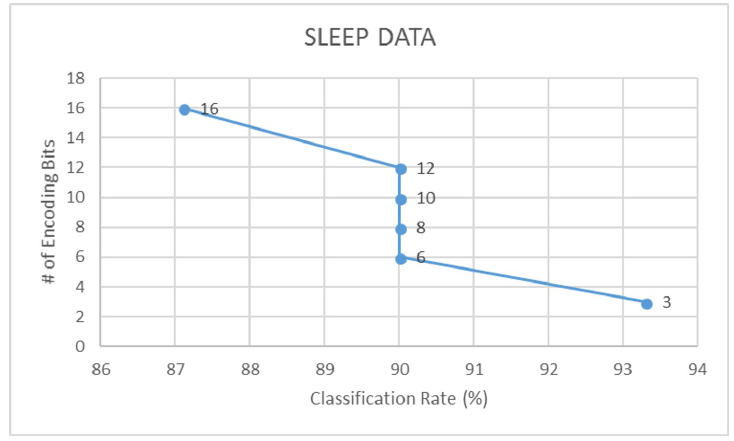
Figure 10. Classification rate vs. encoding - sleep